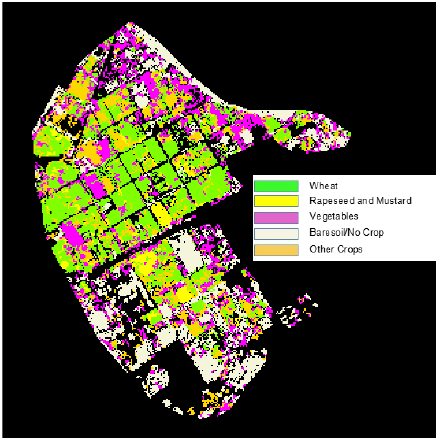
Figure 5. Classified image obtained by classifying Sentinel-2 imagery using Random Forest in GEE.